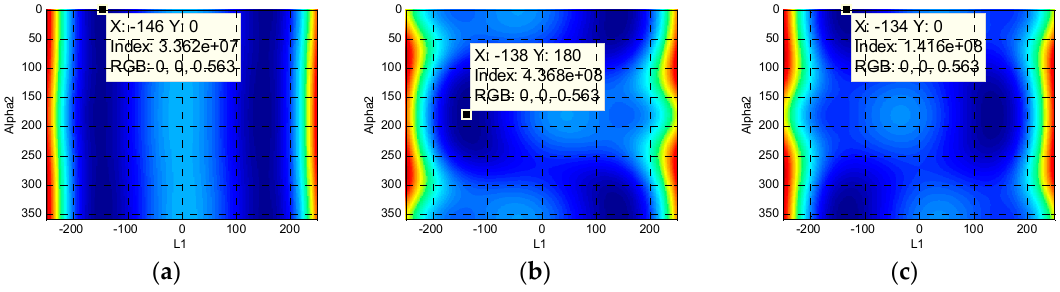
Figure A2. Part of simulation verification of numerical optimization with fixed A 2 . The corresponding parameters are: ( a ) A 2 = 50, i c = 8 ◦ ; ( b ) A 2 = − 200, i c = 12 ◦ ; ( c ) A 2 = 150, i c = 16 ◦